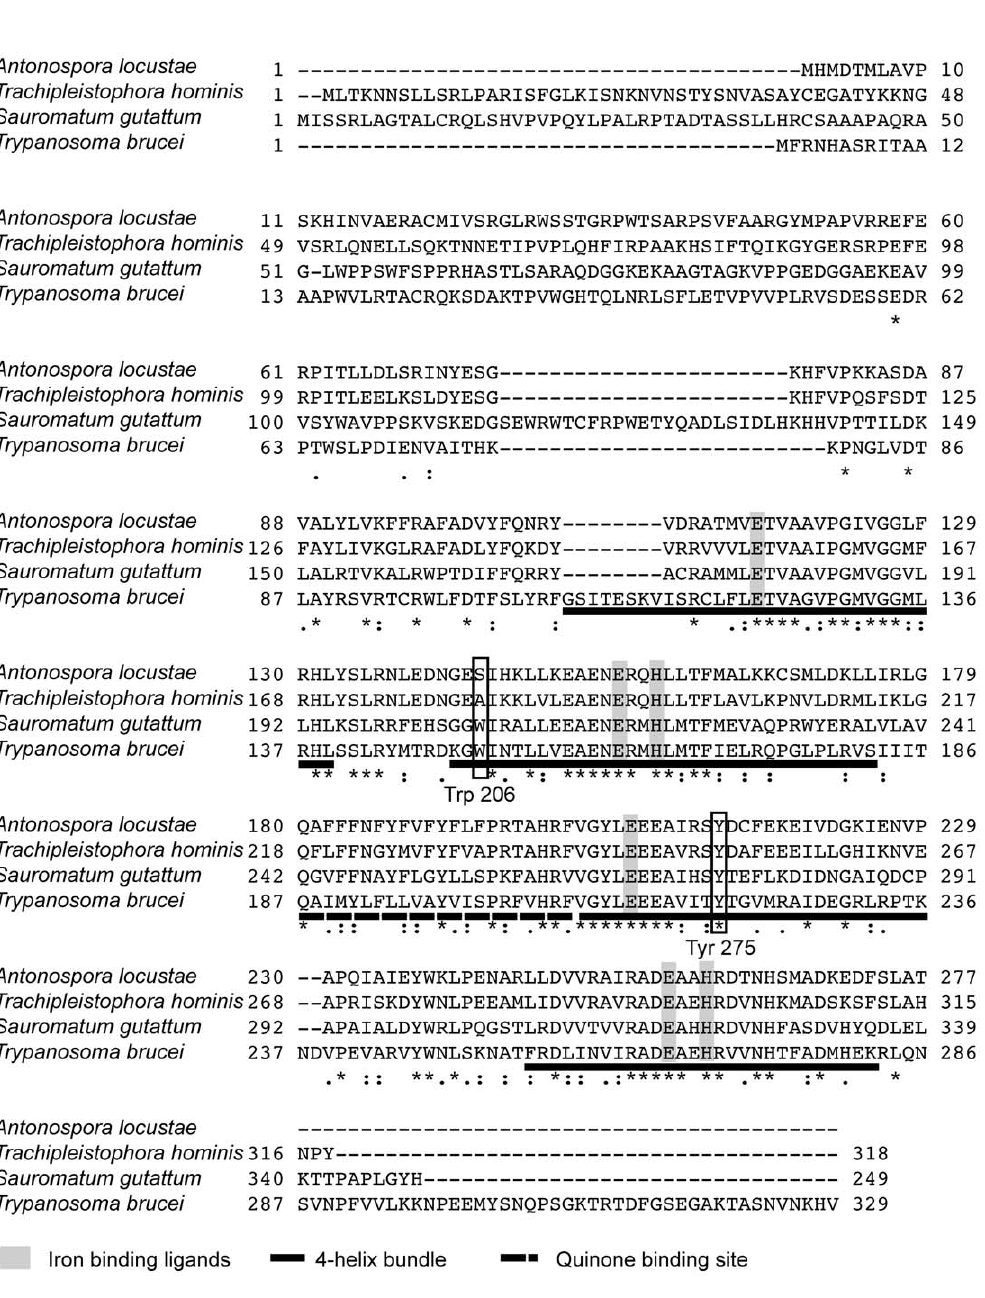
Figure 1. Alignment of A.locustae,T.hominis , S.guttatum and T.brucei AOX sequences. The four-helix bundles are underlined with a solid line. The putative quinone binding site is underlined with a broken line. Conserved amino acid sites are marked with a star and semi conserved sites are marked with dots.